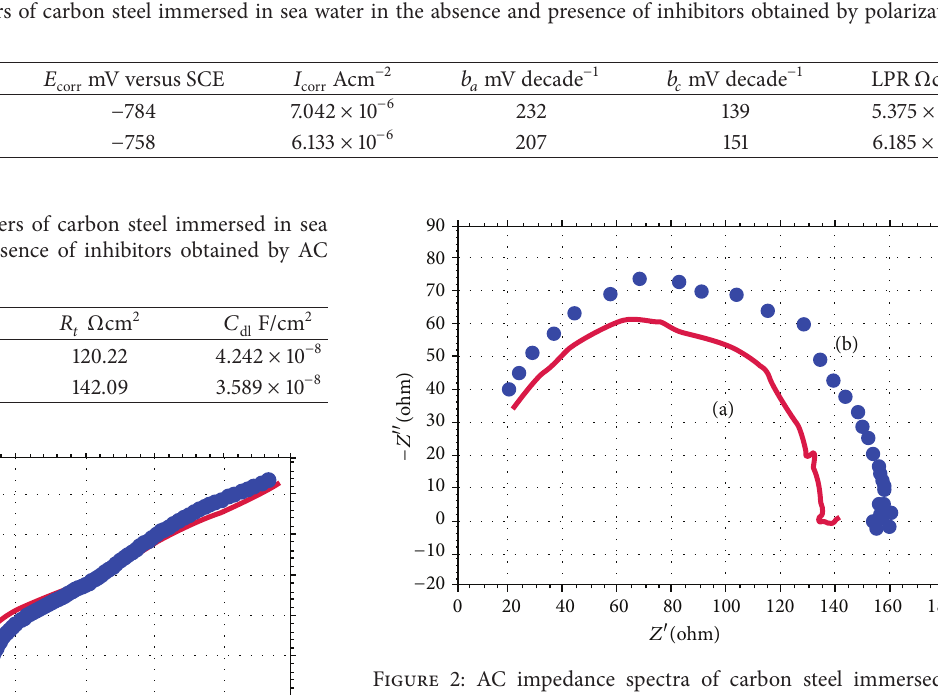
Figure 3(b). The CN stretching frequency has shifted from 1130 to 1095 cm −1 . The C=O stretching frequency shifted from 1689 to 1630 cm −1 . The NH stretching frequency shifted from 3290 to 3422 cm −1 . This indicates that the nitrogen atom